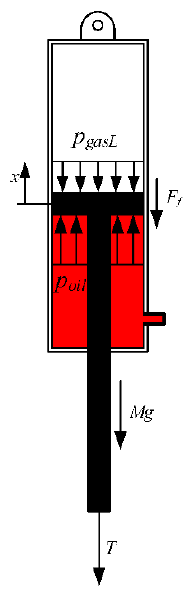
Figure 5. Schematic of hydraulic cylinder.